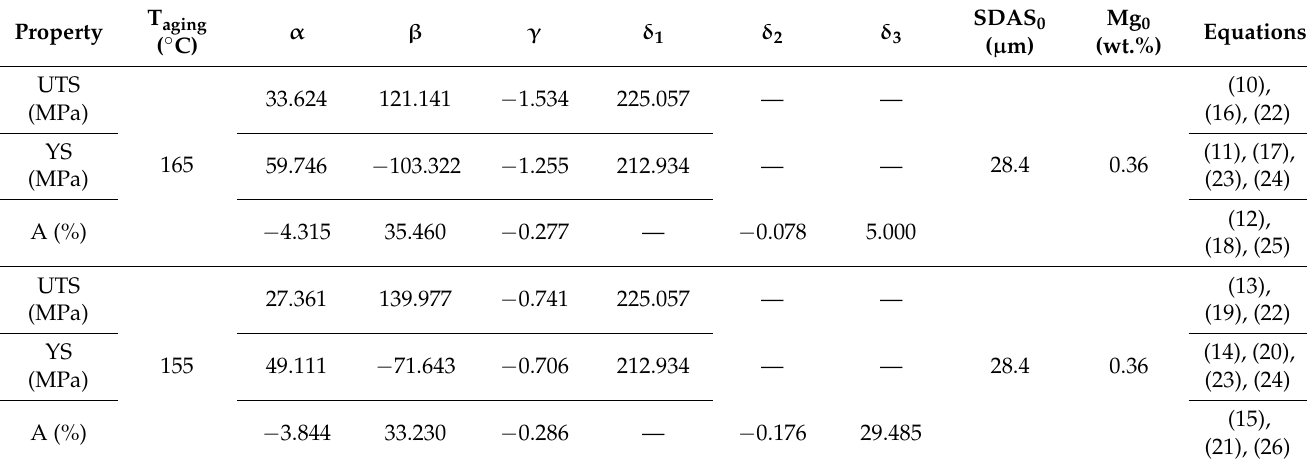
Table 11. Values of coefficients α , β , γ , δ 1 , δ 2 and δ 3 for predicting each tensile property according to expressions 28 and 29. Coefficient δ 1 for YS property is obtained as the average value from Equations (23) and